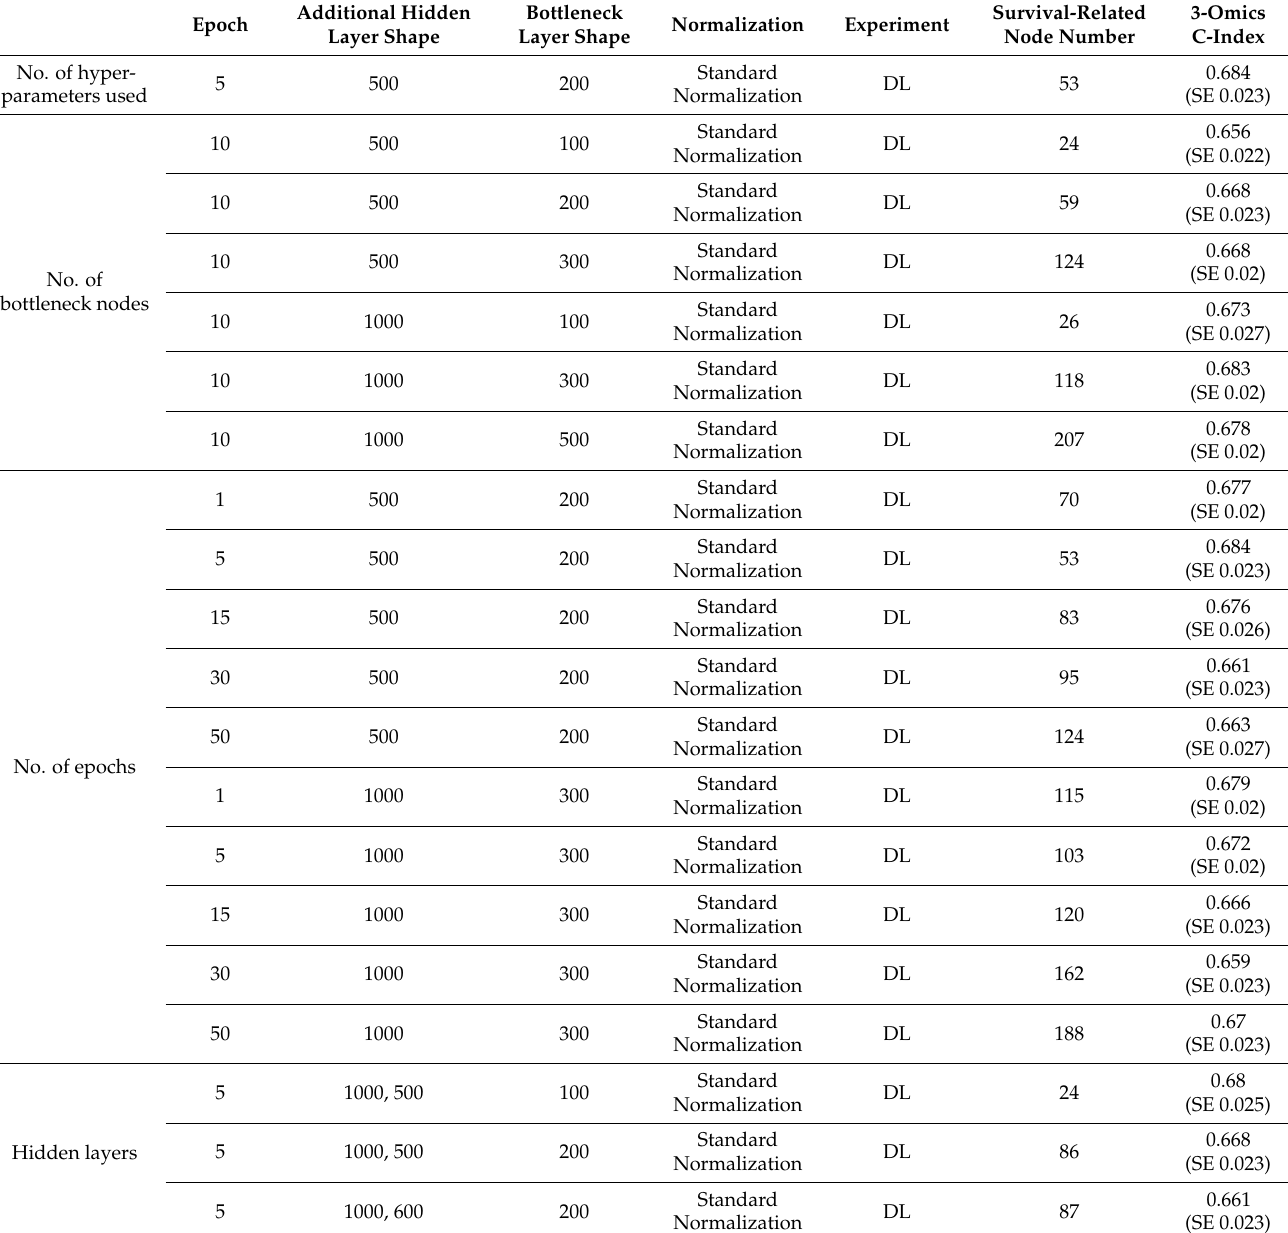
Table 2. Performances of different hyper-parameter values of TCGA three-omics